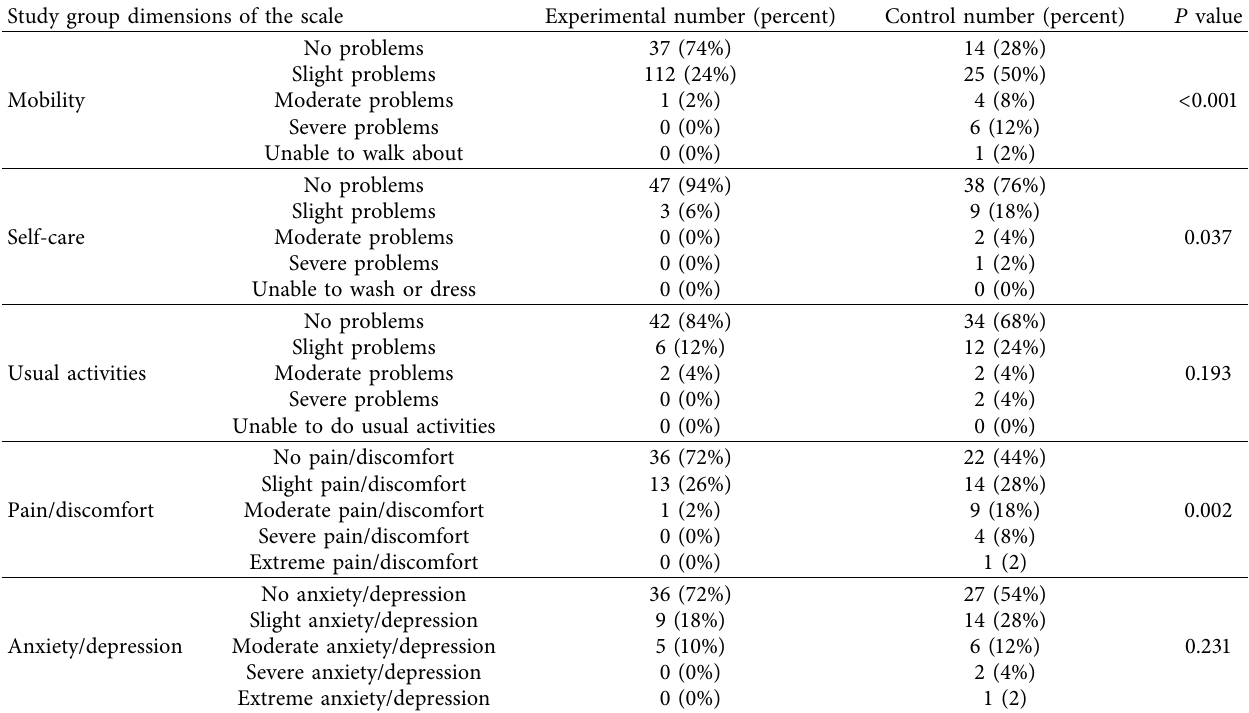
Table 4: Comparison of the frequency distribution of life dimensions after intervention in the studied patients. Study group dimensions of the